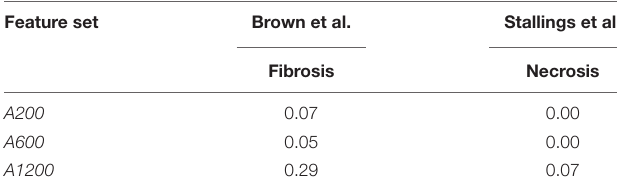
TABLE 9 | Mean F1 scores of arbitrary gene sets in predicting external testing sets. Feature